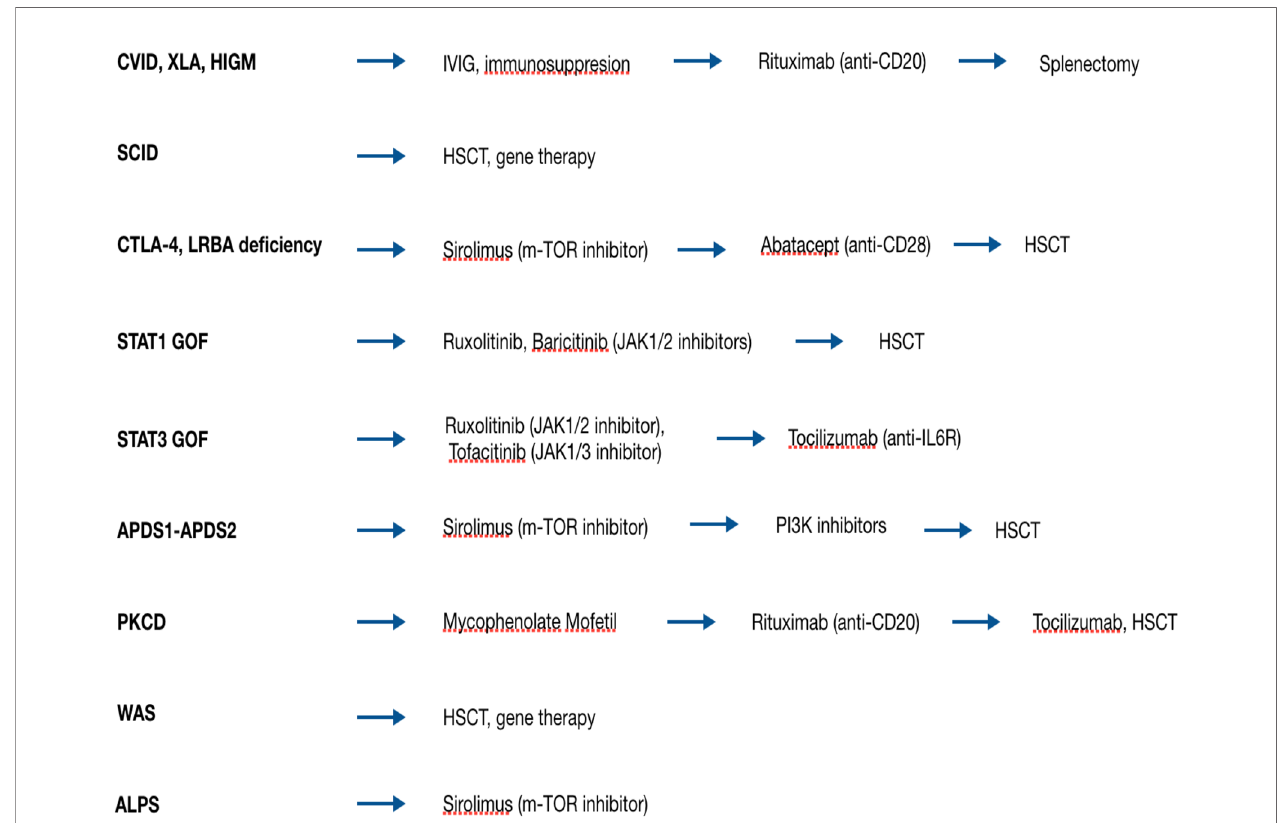
FIGURE 2 | Therapeutic strategies for AICs in patients with